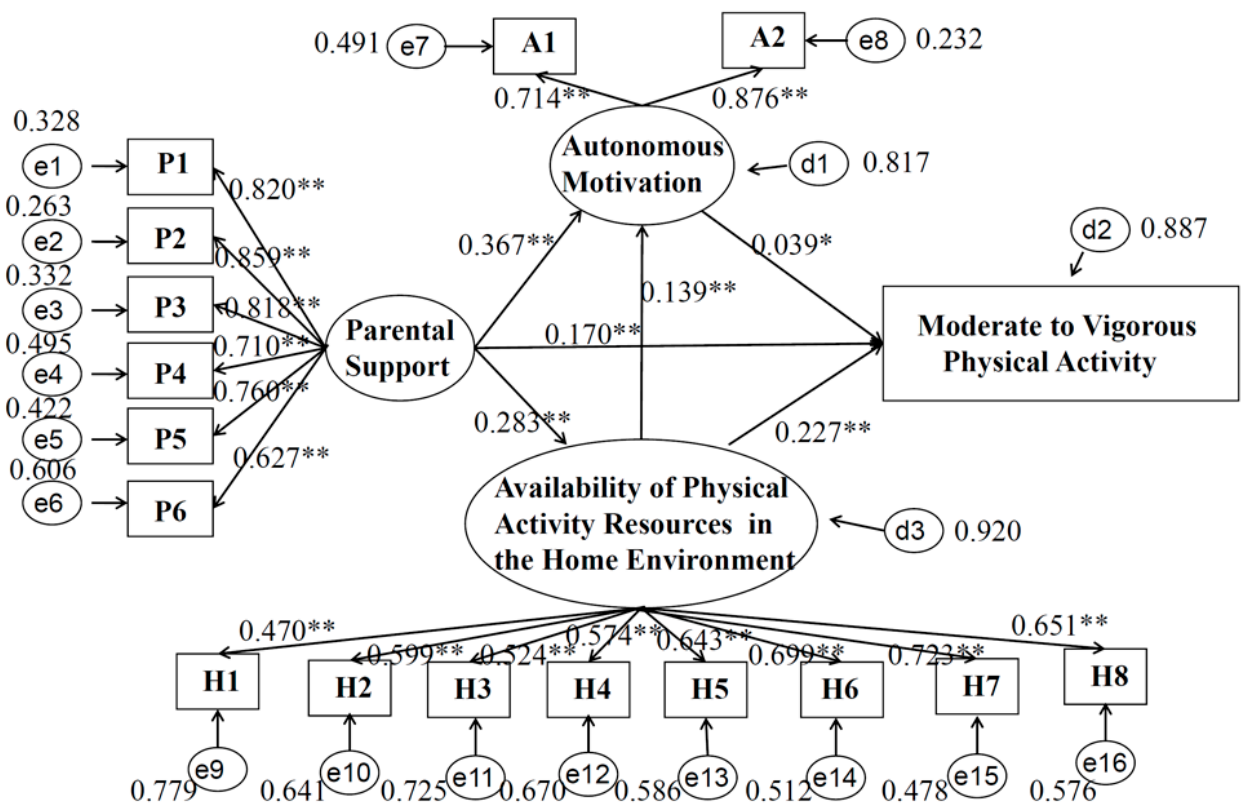
Figure 1. Model of moderate to vigorous physical activity in the total adolescent sample. Note: ** p < 0.001, * p < 0.05. P1, “a. My parent(s) have to make sure that I get enough physical activity”; P2,